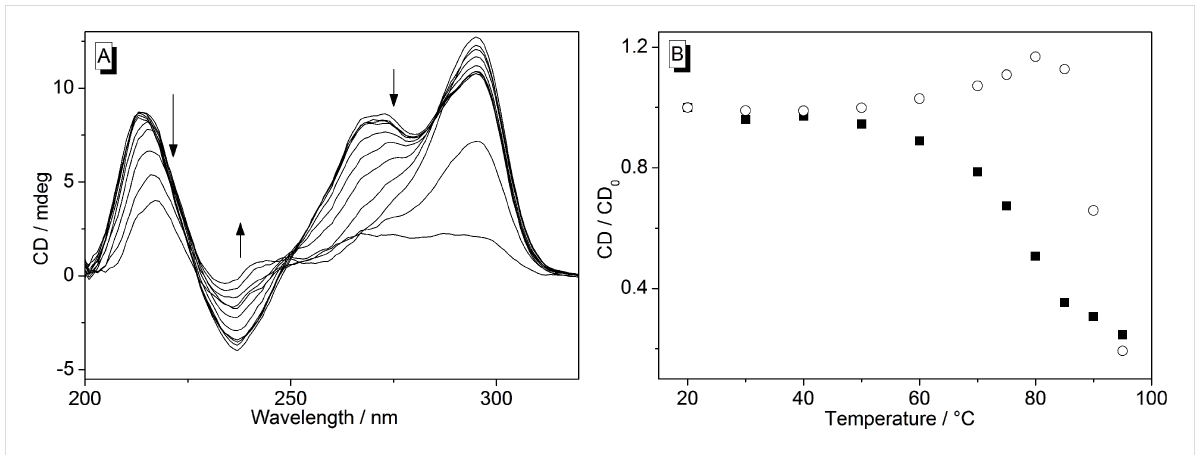
Figure 2: A) CD spectra of ILPR-DNA a2 (20 μ M) at different temperatures in potassium phosphate buffer (95 mM, pH 7.0). Arrows indicate the development of the bands with increasing temperature. B) Plot of the intensity changes (CD/CD 0 ) of the CD signals at 265 nm ( ■ ) and 295 nm ( ○ ) versus